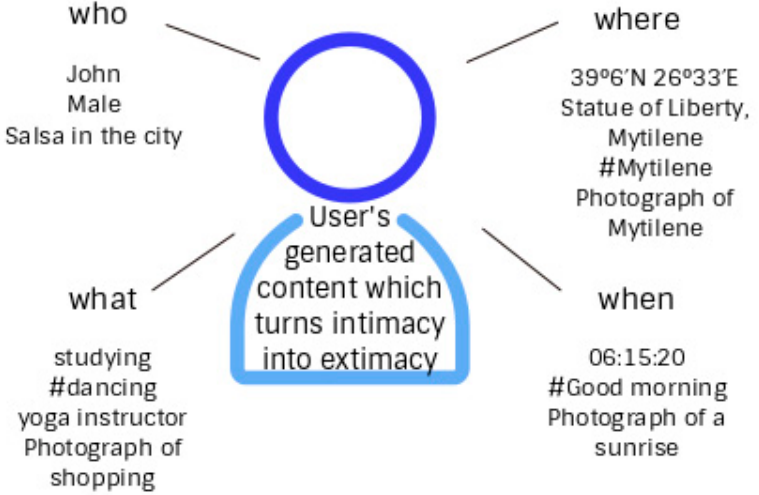
Figure 3. User’s representation through socio-spatial attributes.